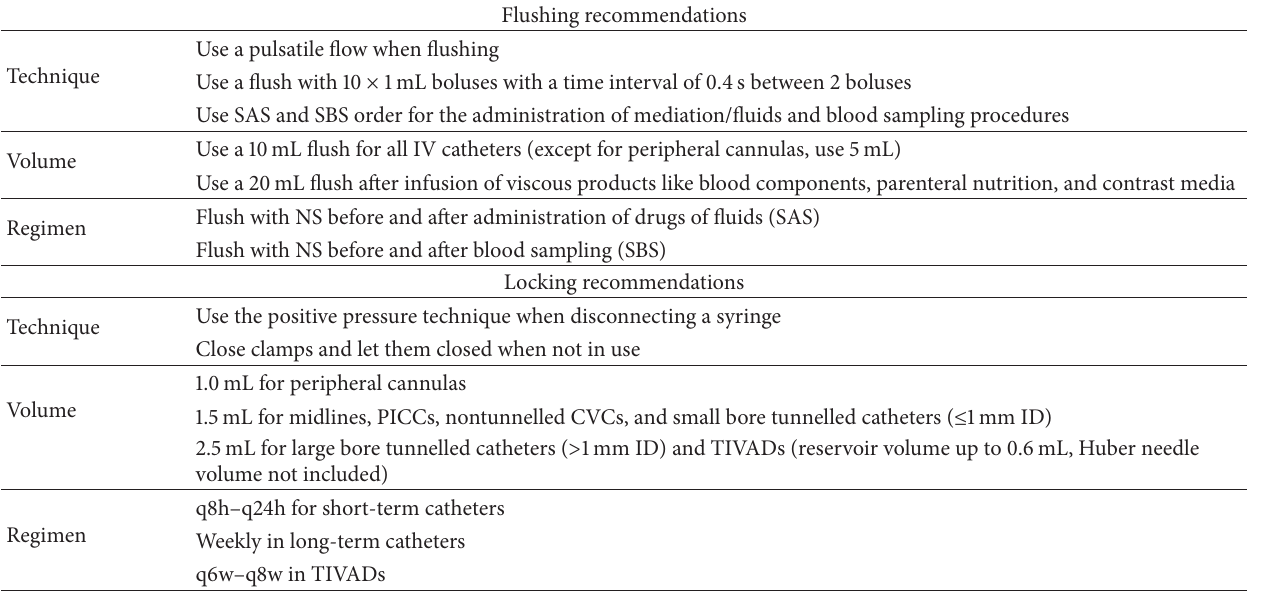
Table 1: Flushing and locking